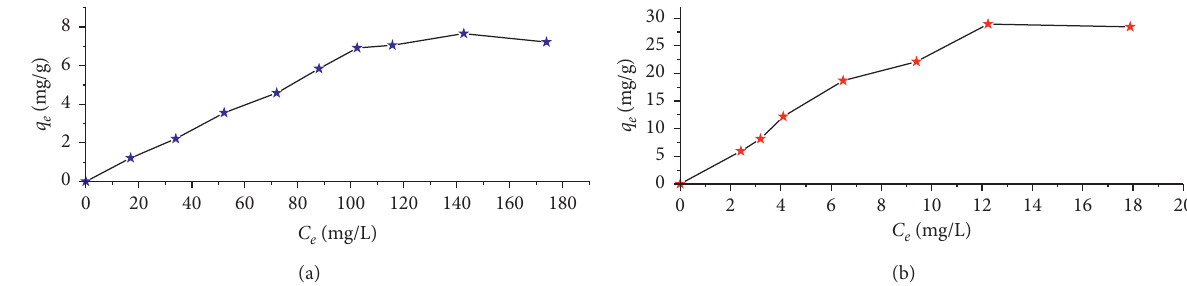
Figure 10: Adsorption isotherms of thymol onto the Rh-P (a) and Rh-CTAB (b).